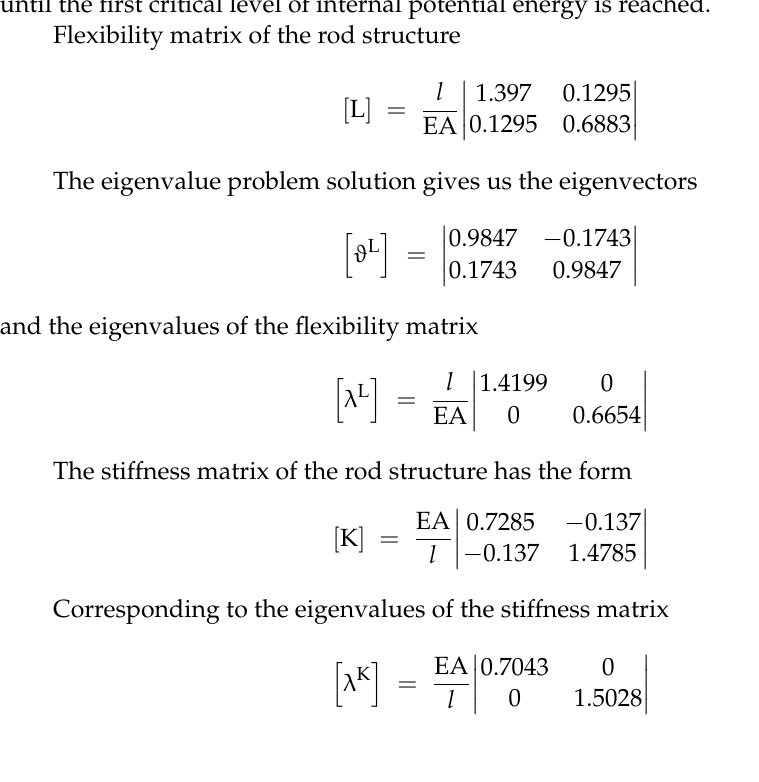
, elastic moduli E , and cross-sectional areas A . In- clined rods are located at the corners